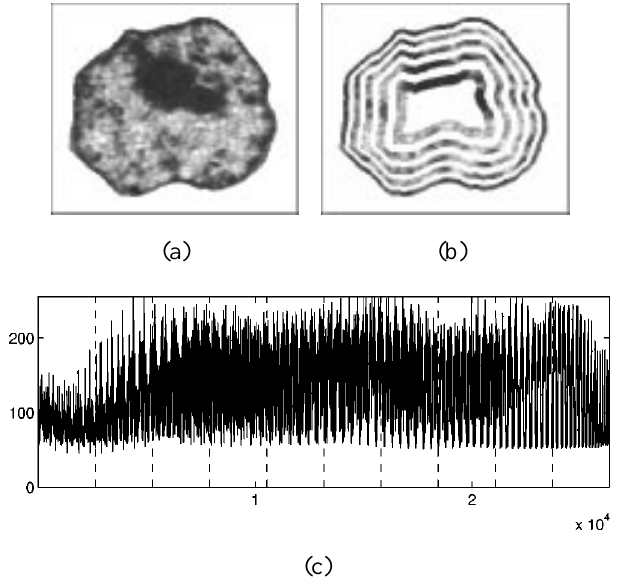
Fig. 1. (a) A malignant cell nucleus, (b) the 2D regions of every second segment (1, 3, 5, 7, 9) and (c) the resulting 1D gray level